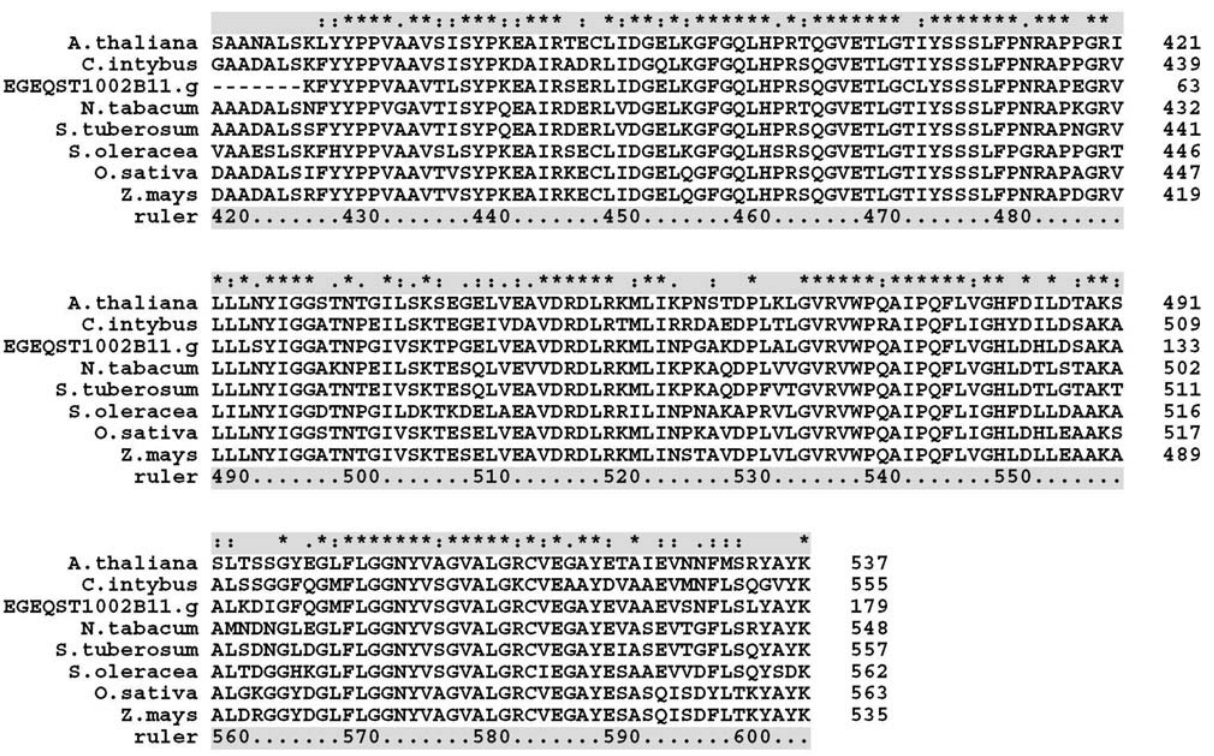
Figure 4 - Fragments of sequences corresponding to the end region of the protoporphyrinogen IX oxidase enzyme from different plant